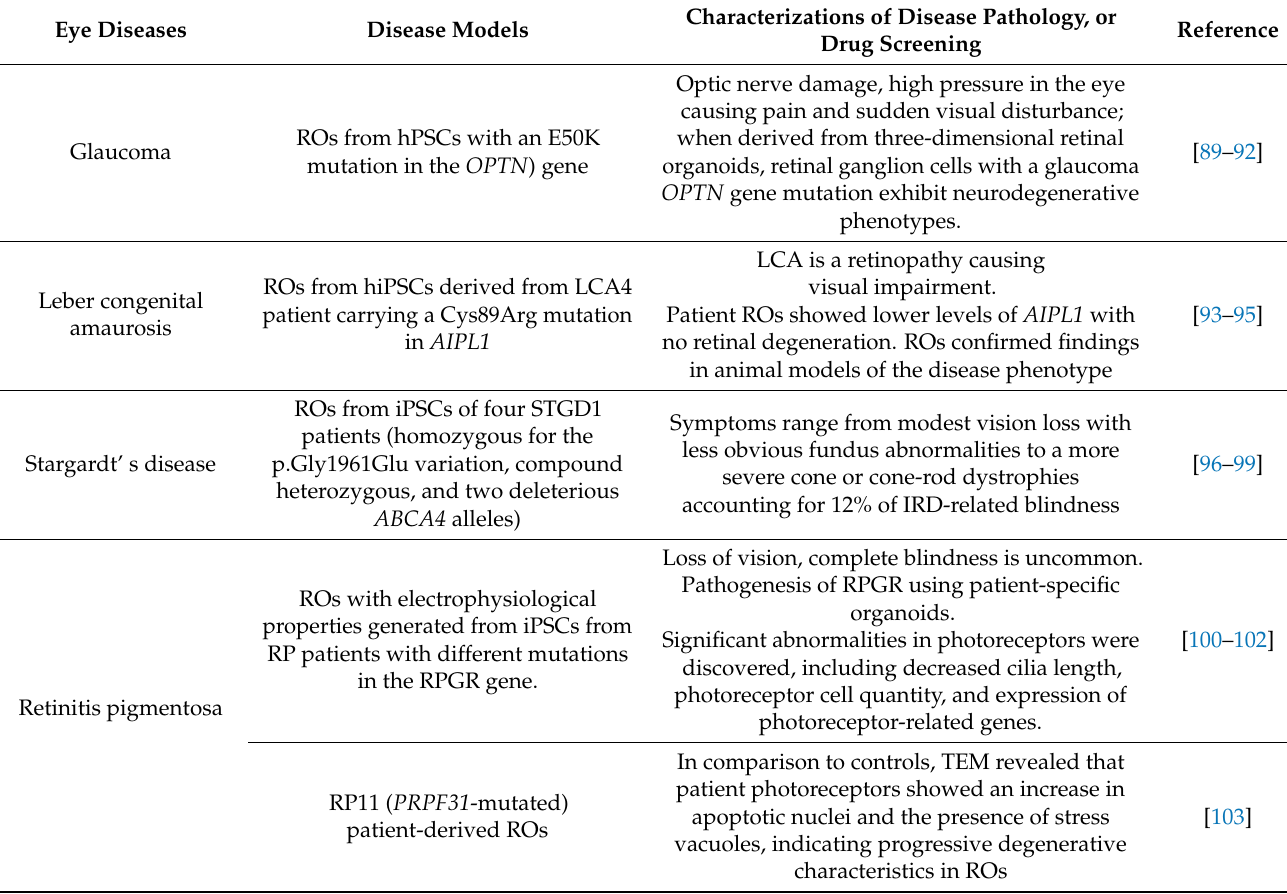
Table 2. Pluripotent stem cell-derived retinal organoids for disease modeling and development of